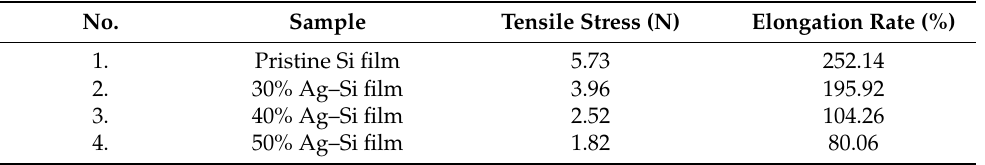
Table 4. The tensile stress and elongation rate of each